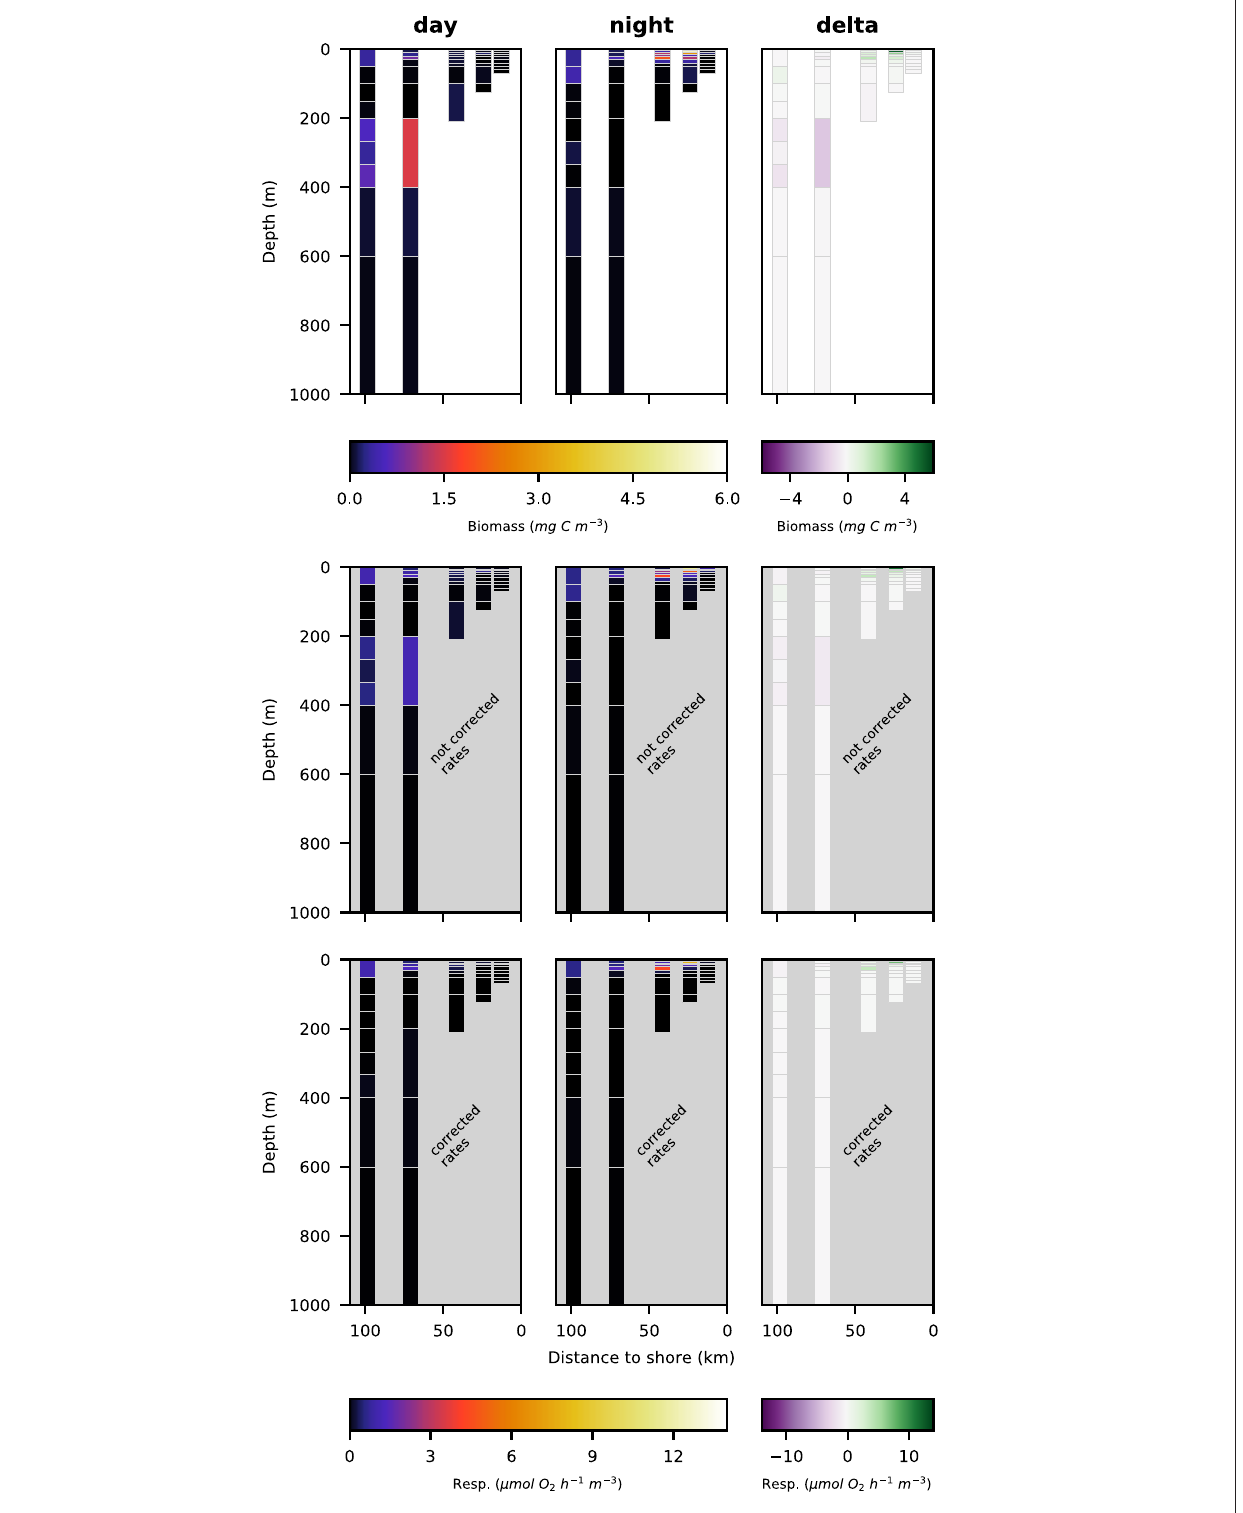
FIGURE 5 | Vertical distribution of total crustacean biomass (top row; mg C m − 3 ), not corrected respiration rates (middle row; µ mol O 2 h − 1 m − 3 ) and corrected respiration rates (bottom row; µ mol O 2 h − 1 m − 3 ) along the transect at day (left panels), night (middle panels), and the difference of the two (right panels).